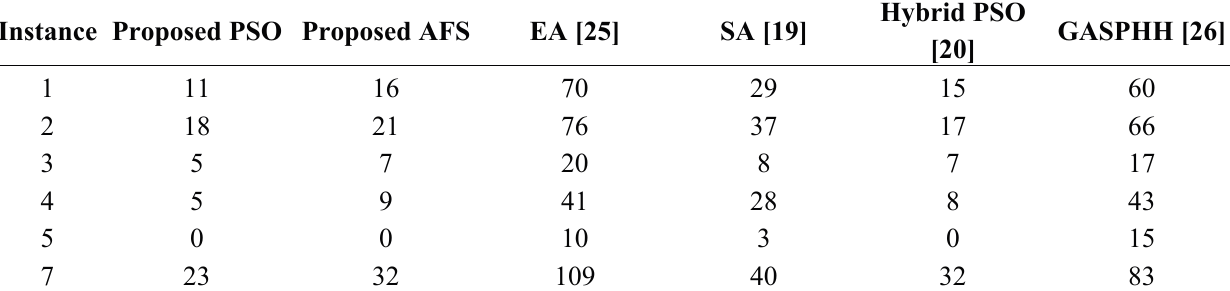
Table 4. Comparing the performance of both proposed algorithms with the algorithms presented in